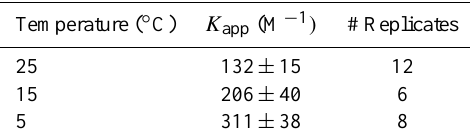
Table 3. Temperature dependence of the apparent equilibrium con- stant ( K app ) of 1-hydroxyethyl hydroperoxide (1-HEHP) formation from